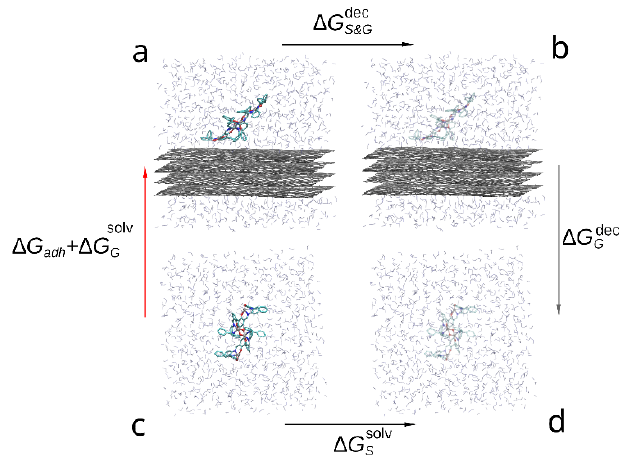
Figure 4. Thermodynamic cycle used to compare the adhesion free energy of the compound to graphene in solvent: ( a ) a bis-(Zn)salphen dimer interacting with graphene surface, ( b ) graphene with the dimer decoupled (shown with transparency), ( c ) dimer solvated in DCM, ( d ) dimer decoupled from solvent. The red arrow ( c - a ) indicates the transformation, the free energy of which contains the target contribution, black arrows ( a - b and d - c ) indicate transformations which are simulated with FEP method and the gray arrow ( b - d )—transformation, the free energy of which is cancelled out.